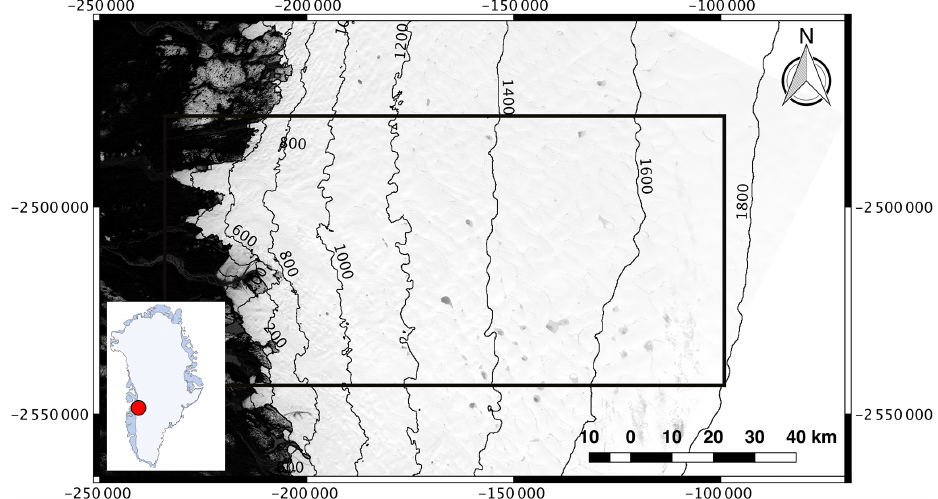
Figure 1. Landsat 8 satellite image, band 2, showing the Russell Glacier area. Black box outlines the study area. Inset shows the location in reference to